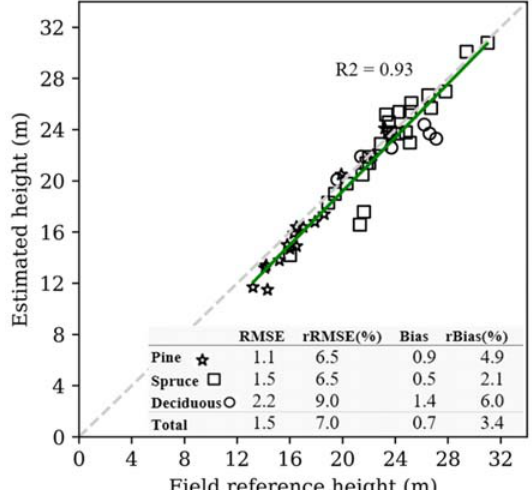
Figure 8. Mean tree height estimation (meter) using watershed segmentation method with SPL data per each and all species